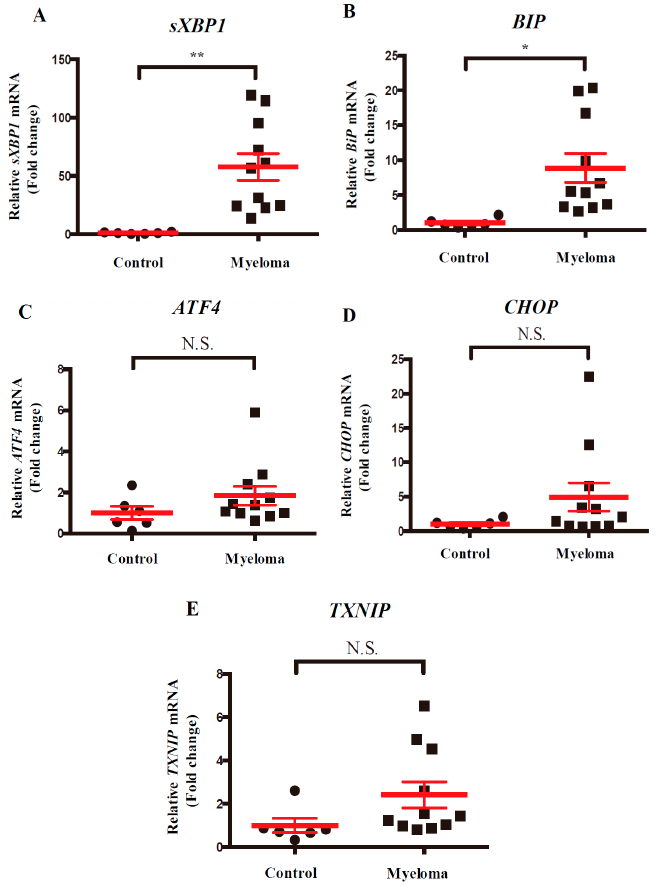
Figure 1. Unfolded protein response (UPR) markers in the bone marrow (BM) of patients with newly diagnosed multiple myeloma (NDMM). Quantitative real-time polymerase chain reaction (RT-PCR) of the relative mRNA levels of sXBP1 ( A ), BIP ( B ), ATF4 ( C ), CHOP ( D ), and TXNIP ( E ) in BM samples of patients with NDMM ( n = 11) and control subjects ( n = 6). Each symbol denotes an individual patient. The data shown are presented as the mean ± standard error of the mean (SEM). N.S., non-significant. * p < 0.05, ** p <